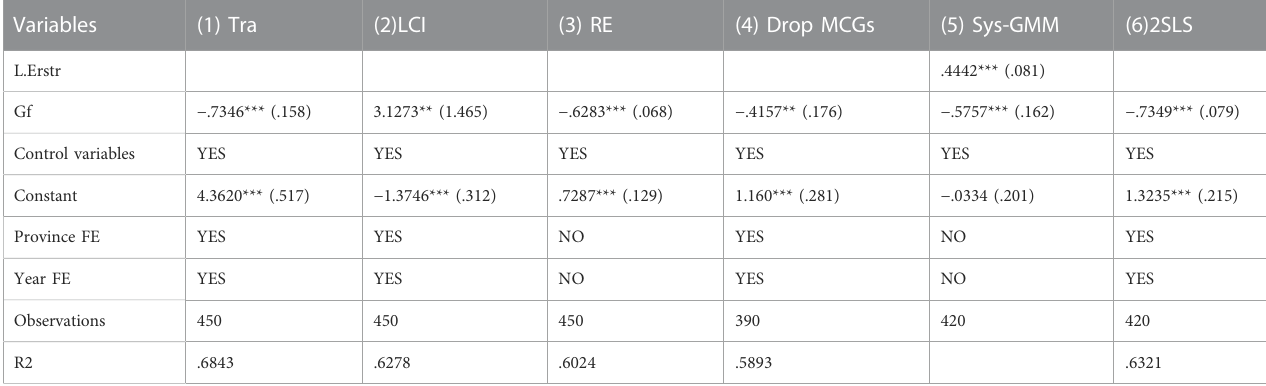
TABLE 5 Robustness test and endogenous check.